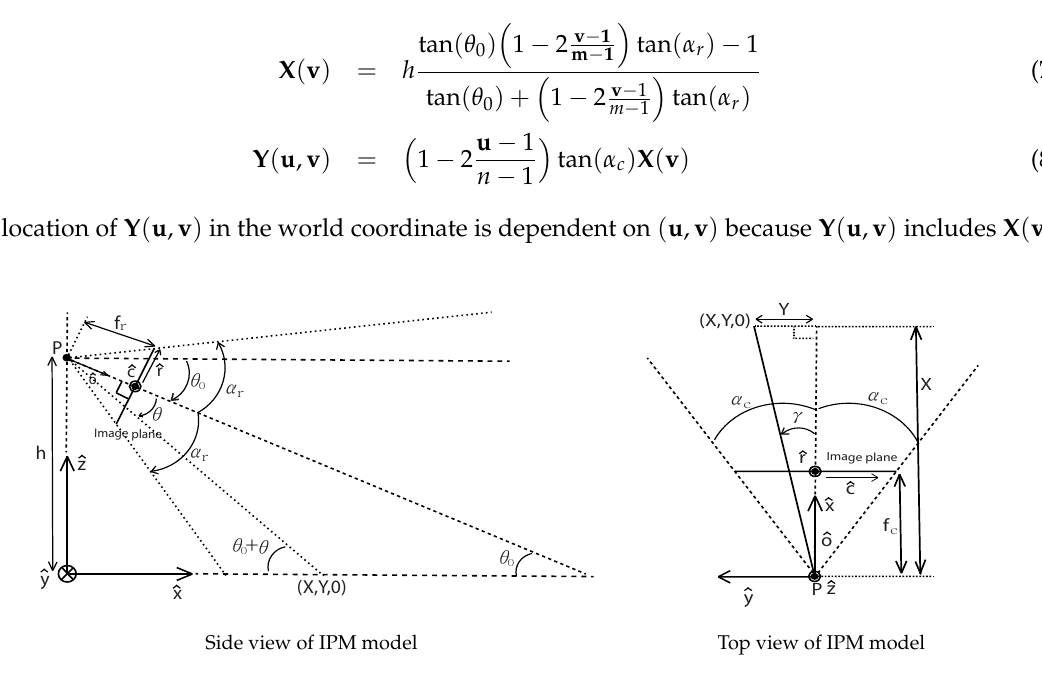
Figure 9. Side and top view of IPM model. In the illustration, f r and f c are the focal length of a camera; θ 0 is the pitch angle; α r and α c are the half angle of the vertical and horizontal field of view (FOV) respectively. Reprinted, with permission, from Jeong et al. URAI 2016; c (cid:13) 2016